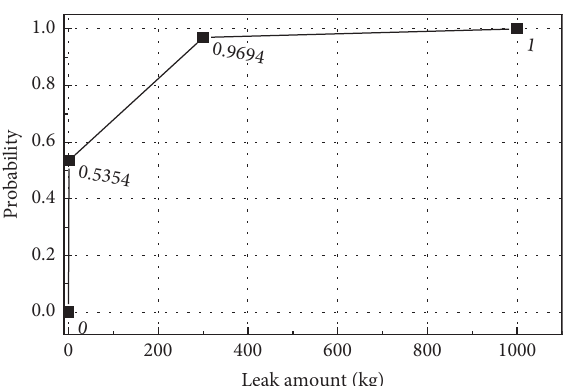
Figure 14: Leak amount cumulative distribution function from 135 FPSOs in